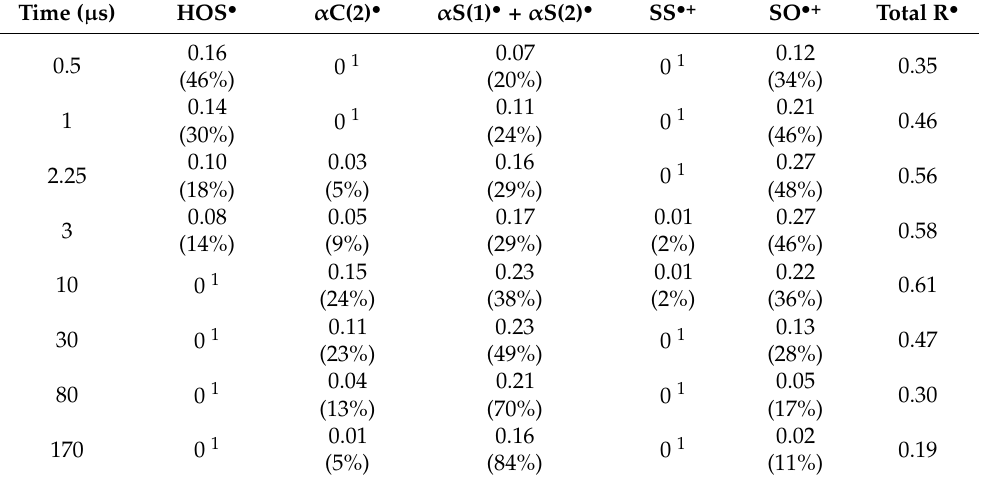
J − 1 , respectively (Table 2). The sum of all component spectra with their respective radiation chemical yields ( G -values) resulted in a good fit ( ⊗ symbols in inset of Figure 2B) to the experimental spectrum. The total G -value of all transient species present (0.61 µ mol J − 1